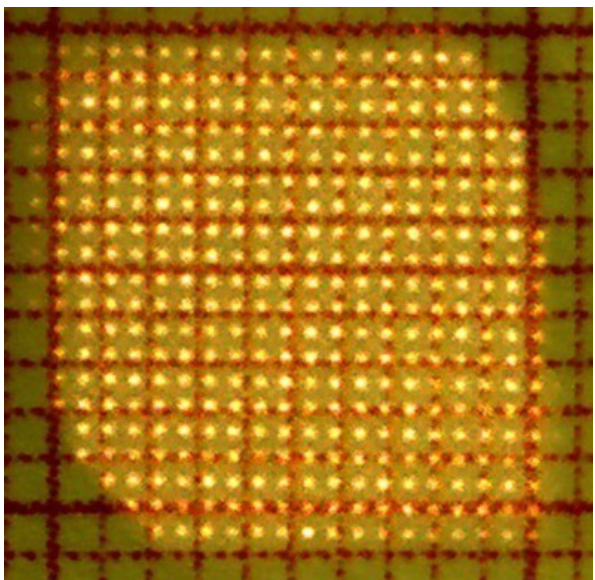
Figure 6. Spots of the excitation laser at about 0.8mm distance from the flat surface of the MLA. The pitch of the scaled paper is 1mm. The slanted shadings at the lower left and at the upper right are due to distance